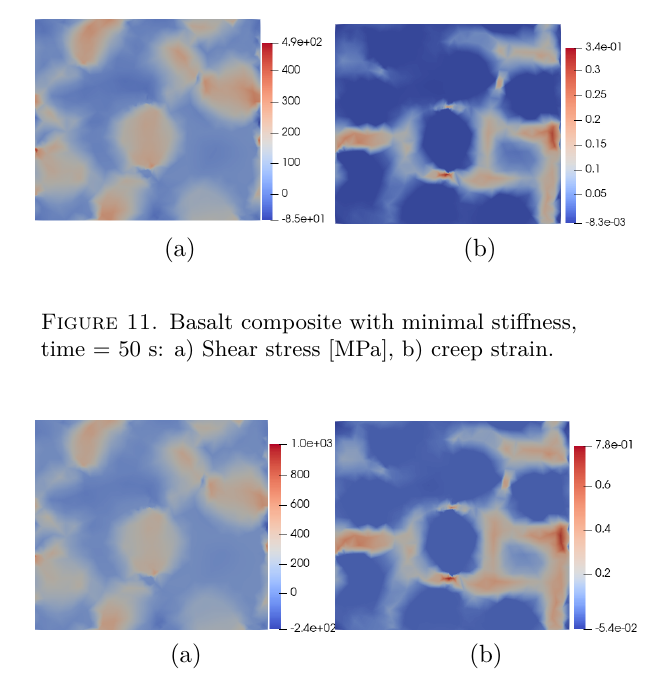
Figure 12. Basalt composite with minimal stiffness, time = 100 s: a) Shear stress [MPa], b) creep strain.